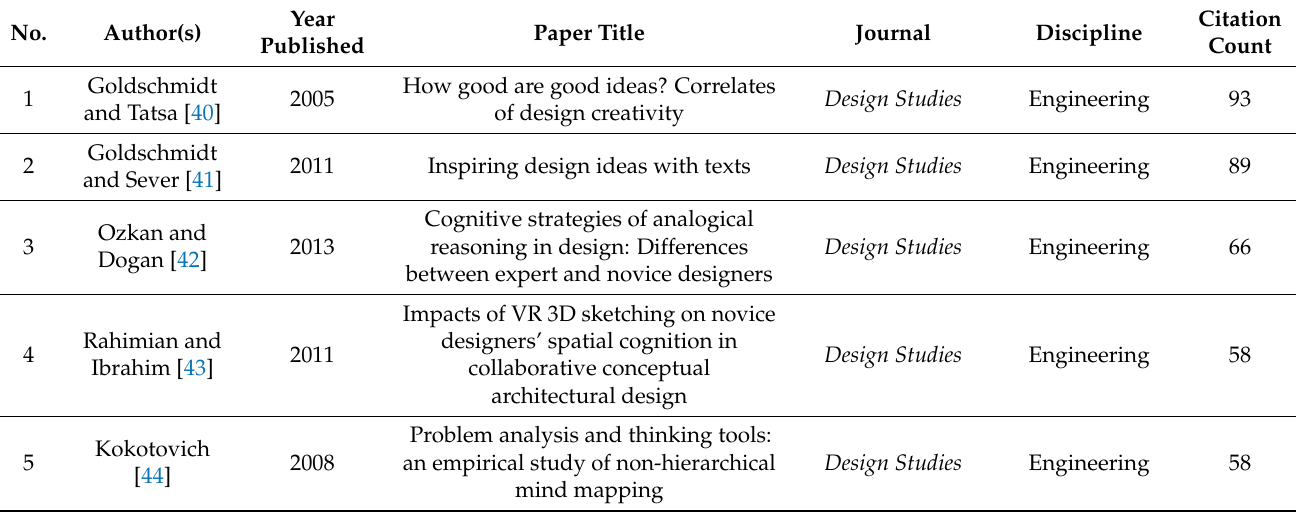
Table 2. The top 10 most cited papers in WoS search results for “Creative thinking for sustainable education in the design studio”.